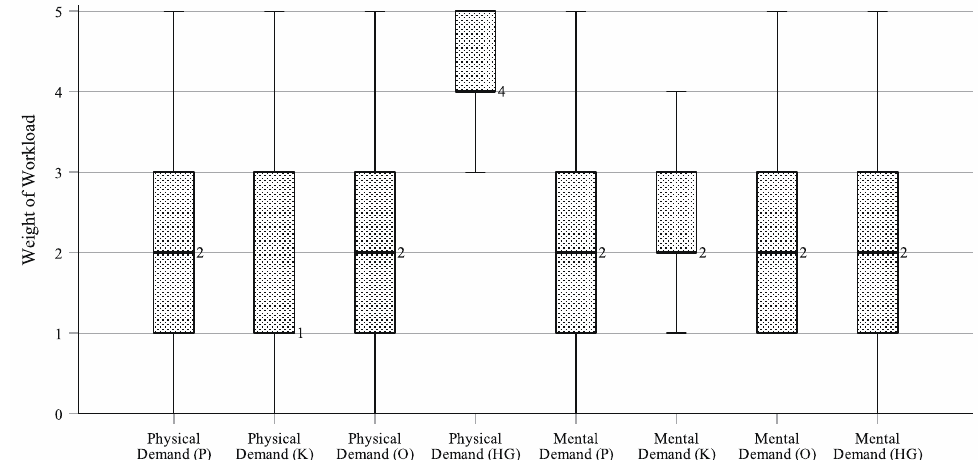
Figure 11. Distribution of the weight of task workload using each approach to MCI by novice group.